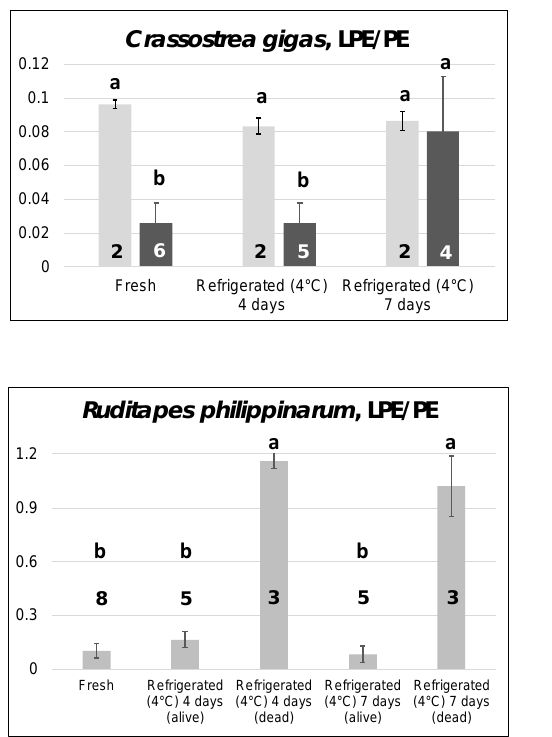
Figure 3. Comparison between lysophosphatidylethanolamines/phosphatidylethanolamines (LPE/PE) and LPC/PC ratios of ESI(+)-FTMS responses obtained from the HILIC–ESI(+)-FTMS analysis of lipid extracts of Japanese oysters ( C. gigas ) and Manila clams ( R. philippinarum ) that were subjected to lipid extraction soon after purchase (as fresh product) or after refrigeration at 4 °C for four or seven days in a laboratory refrigerator. Lighter bars in the graphs related to C. gigas represent data obtained for two lots of fresh oysters purchased in July, displaying anomalously high LPE/PE ratios (see text for an explanation for this finding). Mean values and standard deviations (indicated as error bars) reported relate to the number of replicates indicated for each type of sample. The results of a Tukey–Kramer test are reported in the form of sample type grouping, emphasized by letters. See text for details on the calculation of the LPE/PE and LPC/PC ratios from HILIC–ESI(+)-FTMS XIC chromatograms.